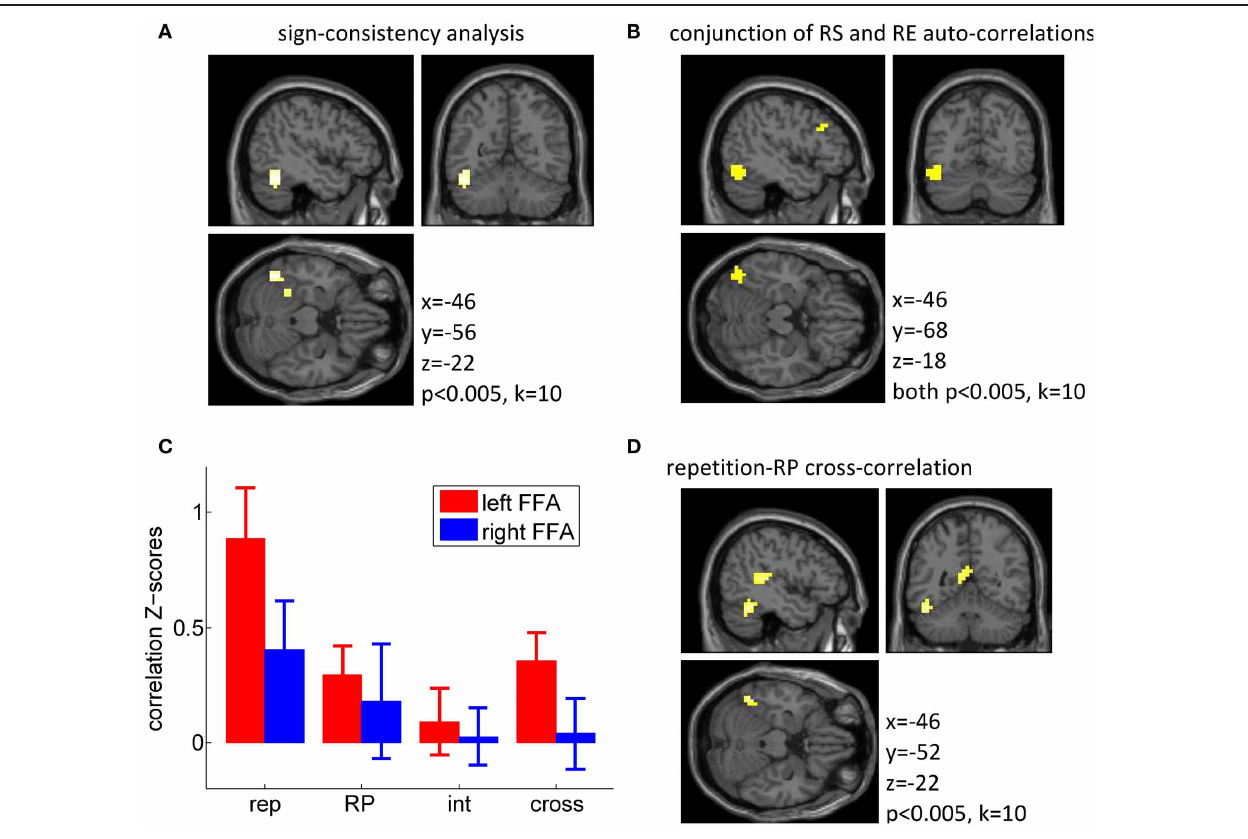
FIGURE 3 | Multivariate fMRI data. (A) Searchlight analysis for the sign-consistency measure (see main text for details) indicating significant segregation of repetition suppression (RS) and repetition enhancement (RE) voxels. (B) Result from the conjunction analysis showing locations at which separate MVPA analyses for repetition suppression voxels and repetition enhancement voxels both indicated significant repetition-repetition